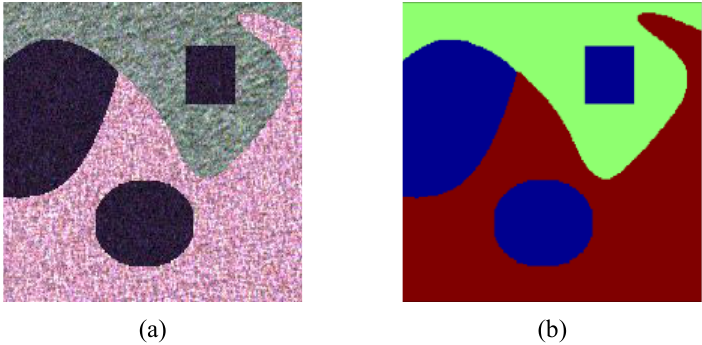
Figure 8. Simulated data set of 400 × 400. ( a ) Pauli-RGB image. ( b ) Ground-truth map.